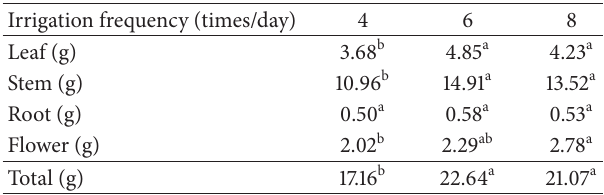
Table 8: Effect of irrigation frequencies on leaf dry weight, stem dry weight, root dry weight, flower dry weight, and total dry